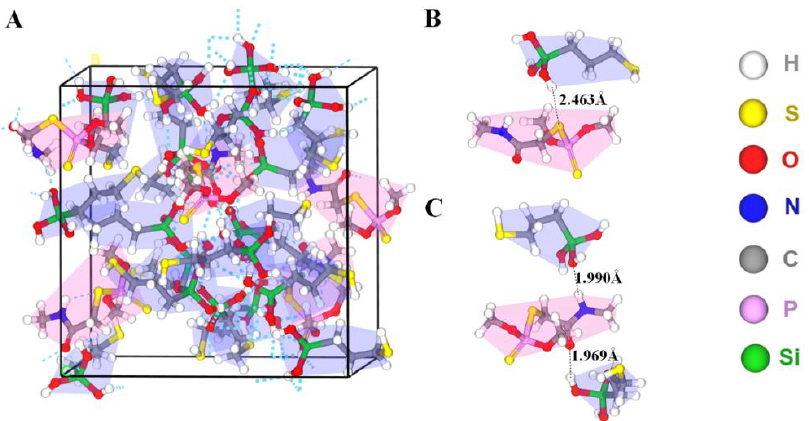
Figure 4. ( A ) Prepolymer system of dimethoate (red background) and MPTMS (blue background). ( B – C ) Two different kinds of hydrogen bonding between dimethoate and MPTMS.